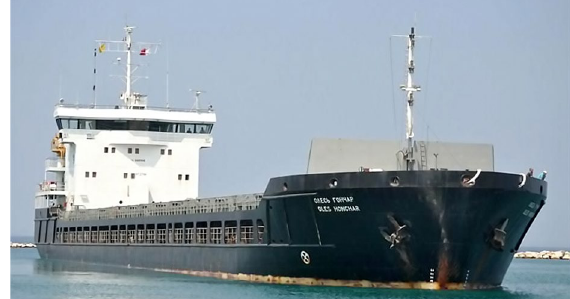
Fig. 7. Dry cargo ship Oles Honchar with the deadweight of 6315 tons (MarineTraffic 2015)